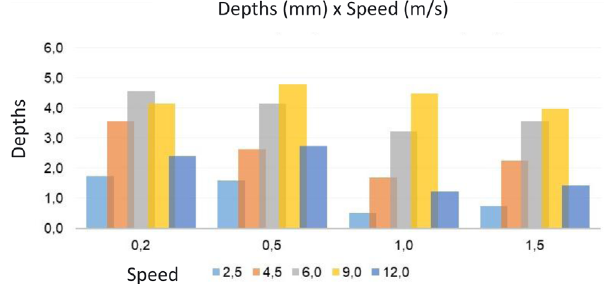
Fig. 15. Diameters measured by the PIG for v =0.2; 0.5; 1.0; 1.5m/s.